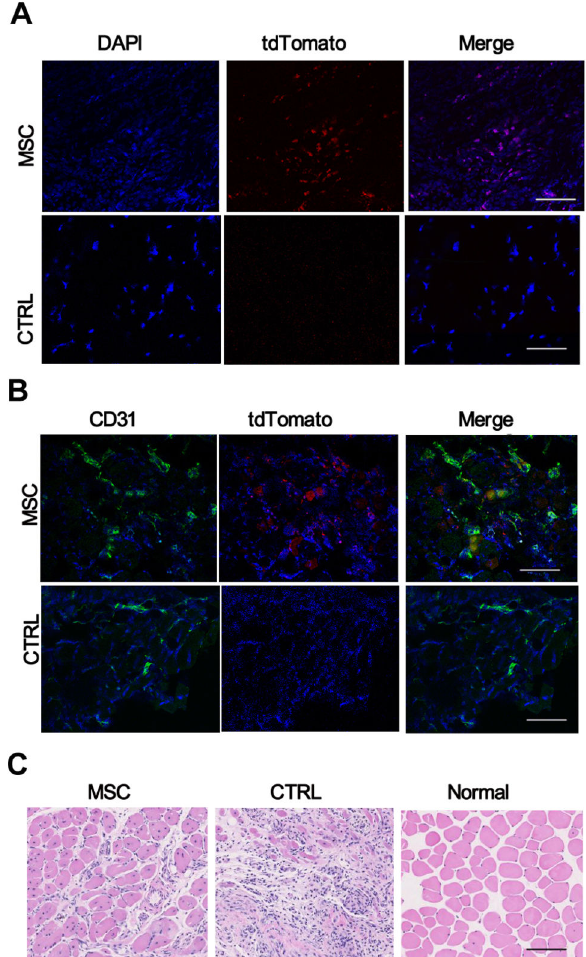
Figure 10. Histological analysis of MSCs survival in ischemic hindlimb. (A) Fluorescence images confirmed the residence of MSCs (red) in ischemic hindlimb in MSC group (upper panel), but not in PBS control group (lower panel). (B) Immunofluorescence staining of endothelial marker CD31 (green), tdTomato (red), and DAPI nuclear dye (blue) suggested that the surviving MSCs in the ischemic hindlimb associated with capillaries. (C) Representative histology from histological analyses of normal limbs and ischemic limbs retrieved 4 weeks after treatment. H&E staining of the peri- infarct zone demonstrate massive muscle degeneration in the ischemic regions of control limbs. In contrast, muscles in the ischemic limbs of the MSCs transplantation group were protected after cell transplantation (Scale bars =